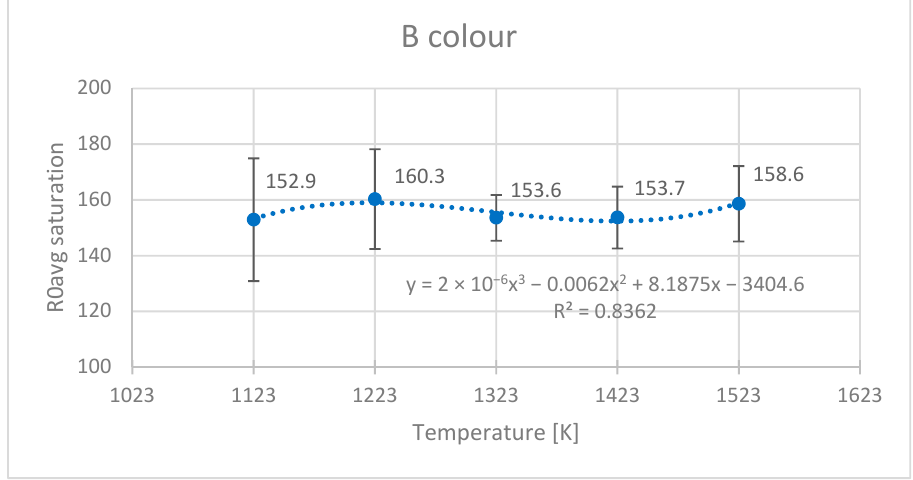
Figure 15. Mean R0 saturation of the B colour. (Reprinted with permission from Ref. [8]. 2022, AFIT.)